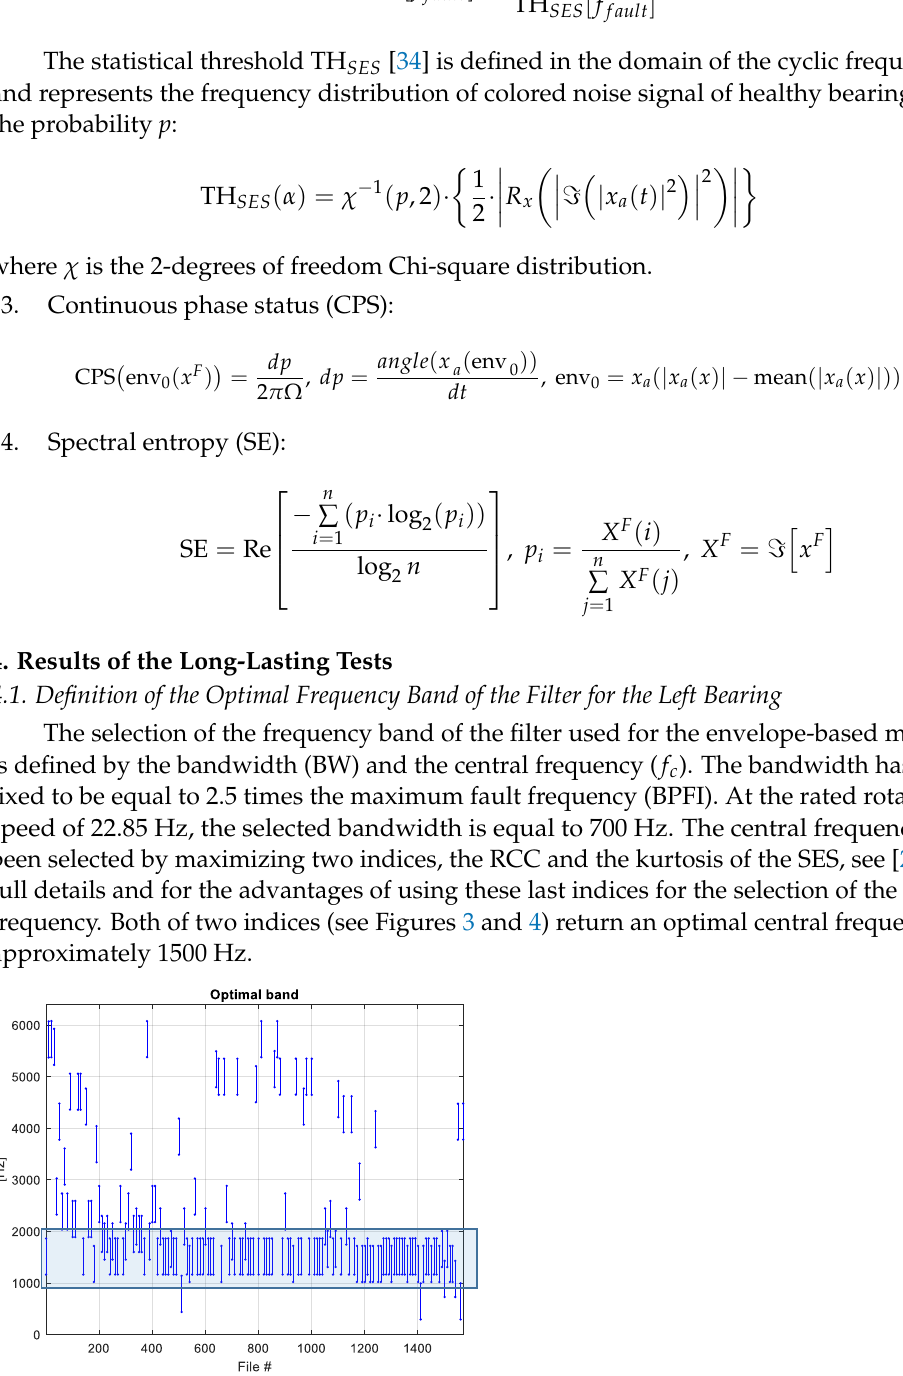
Figure 4. Definition of the optimal frequency band for filtering the residual signal according to the SES index—left TB. 4.2. Fault Detection and Localization for the Left Bearing Figures 5 and 6 show, respectively, the normalized SES and its map for all the ana- lyzed records. The presence of a fault in the outer race of the left TB (1xBPFO and 2xBPFO) is clear in Figure 6, and it develops after a certain period of time (i.e., the first records do not show this damage). It is also possible to observe the deviation of the fault frequency in Figure 6, probably due to the alternating axial load.